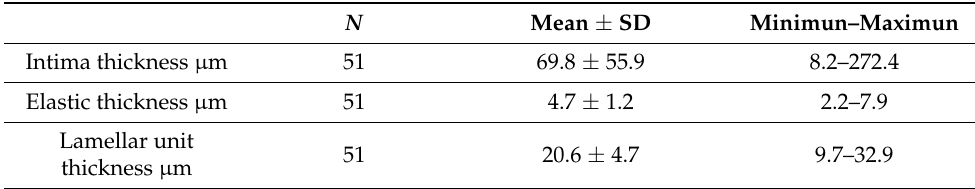
Table 5. Mean ± SD and maximum and minimum values in all the families.